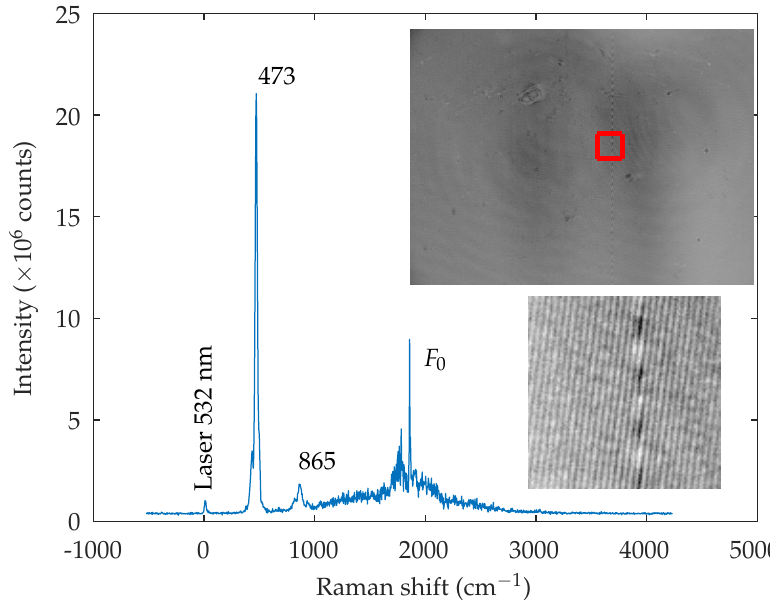
Figure 10. The Raman signal of sulfur. The inset shows the interferogram and a magnified section (outlined with red), where the line of zero path difference is observable. Raman bands of sulfur can be detected at Raman shifts of 473 cm − 1 and 865 cm − 1 . The central part of the spectrum, noted with F 0 , presents the artifacts from the low frequency part of the spectrum, with a narrow and intense spike at the wave number shift equal to the